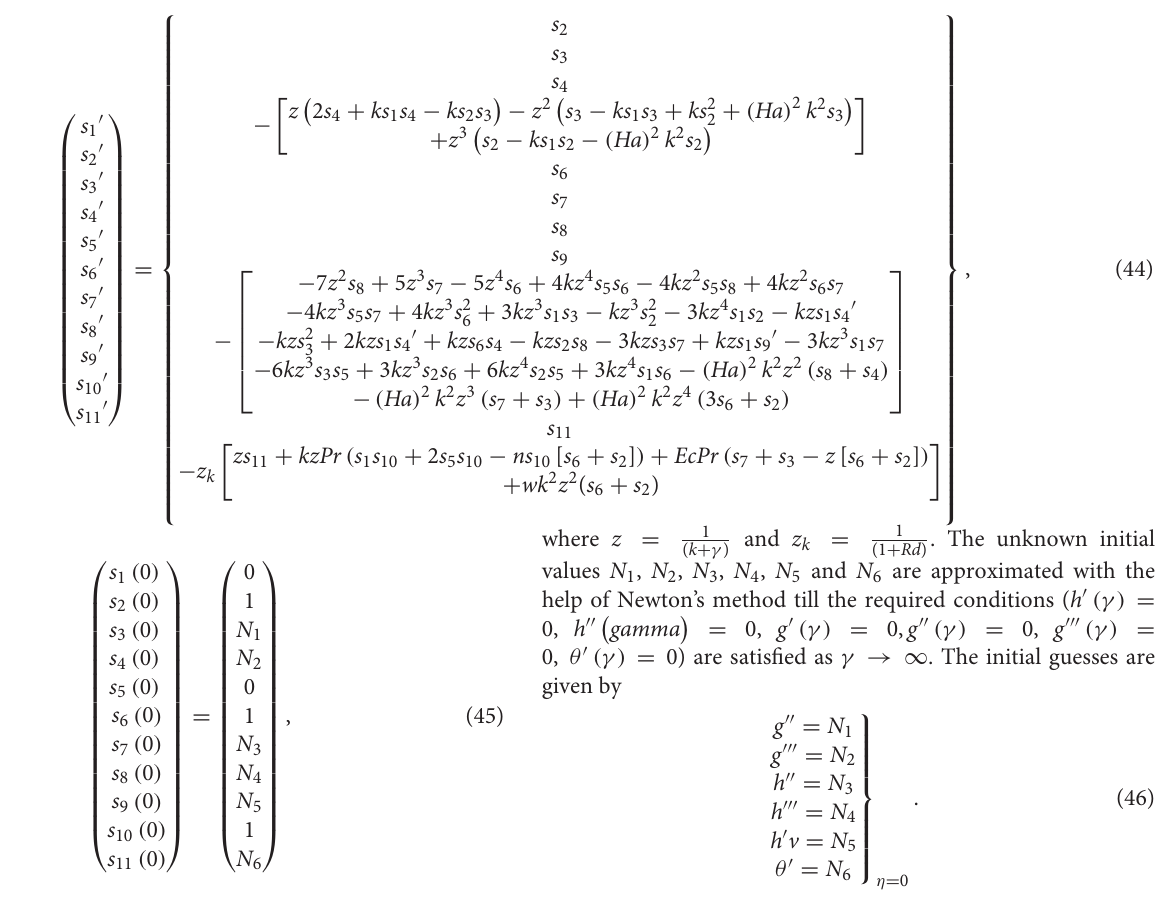
FIGURE 3 | (A) Effects of k on velocity field u ( γ ). (B) Effects of Ha on velocity field u ( γ ). (C) Effects of a on velocity field u ( γ ). (D) Effects of b on velocity field u ( γ